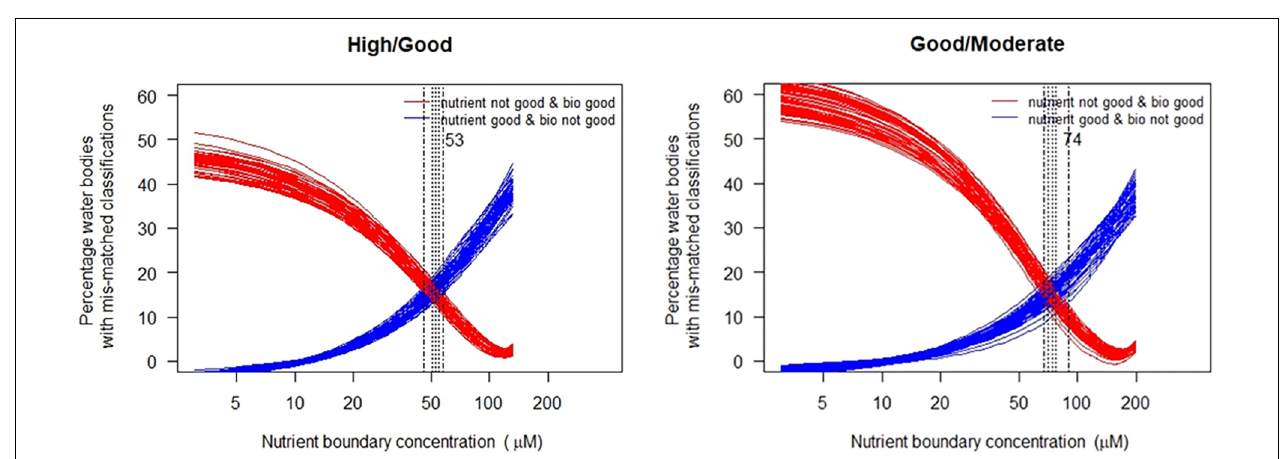
FIGURE 6 | Relationship between percentage of mis-classified records when biological and nutrient classifications are compared for the NEA11 common estuarine type. Vertical lines mark the range of cross-over points where the mis-classification is minimized, together with the mean nutrient concentration. (each line shows a sub-sample of the data set selected at